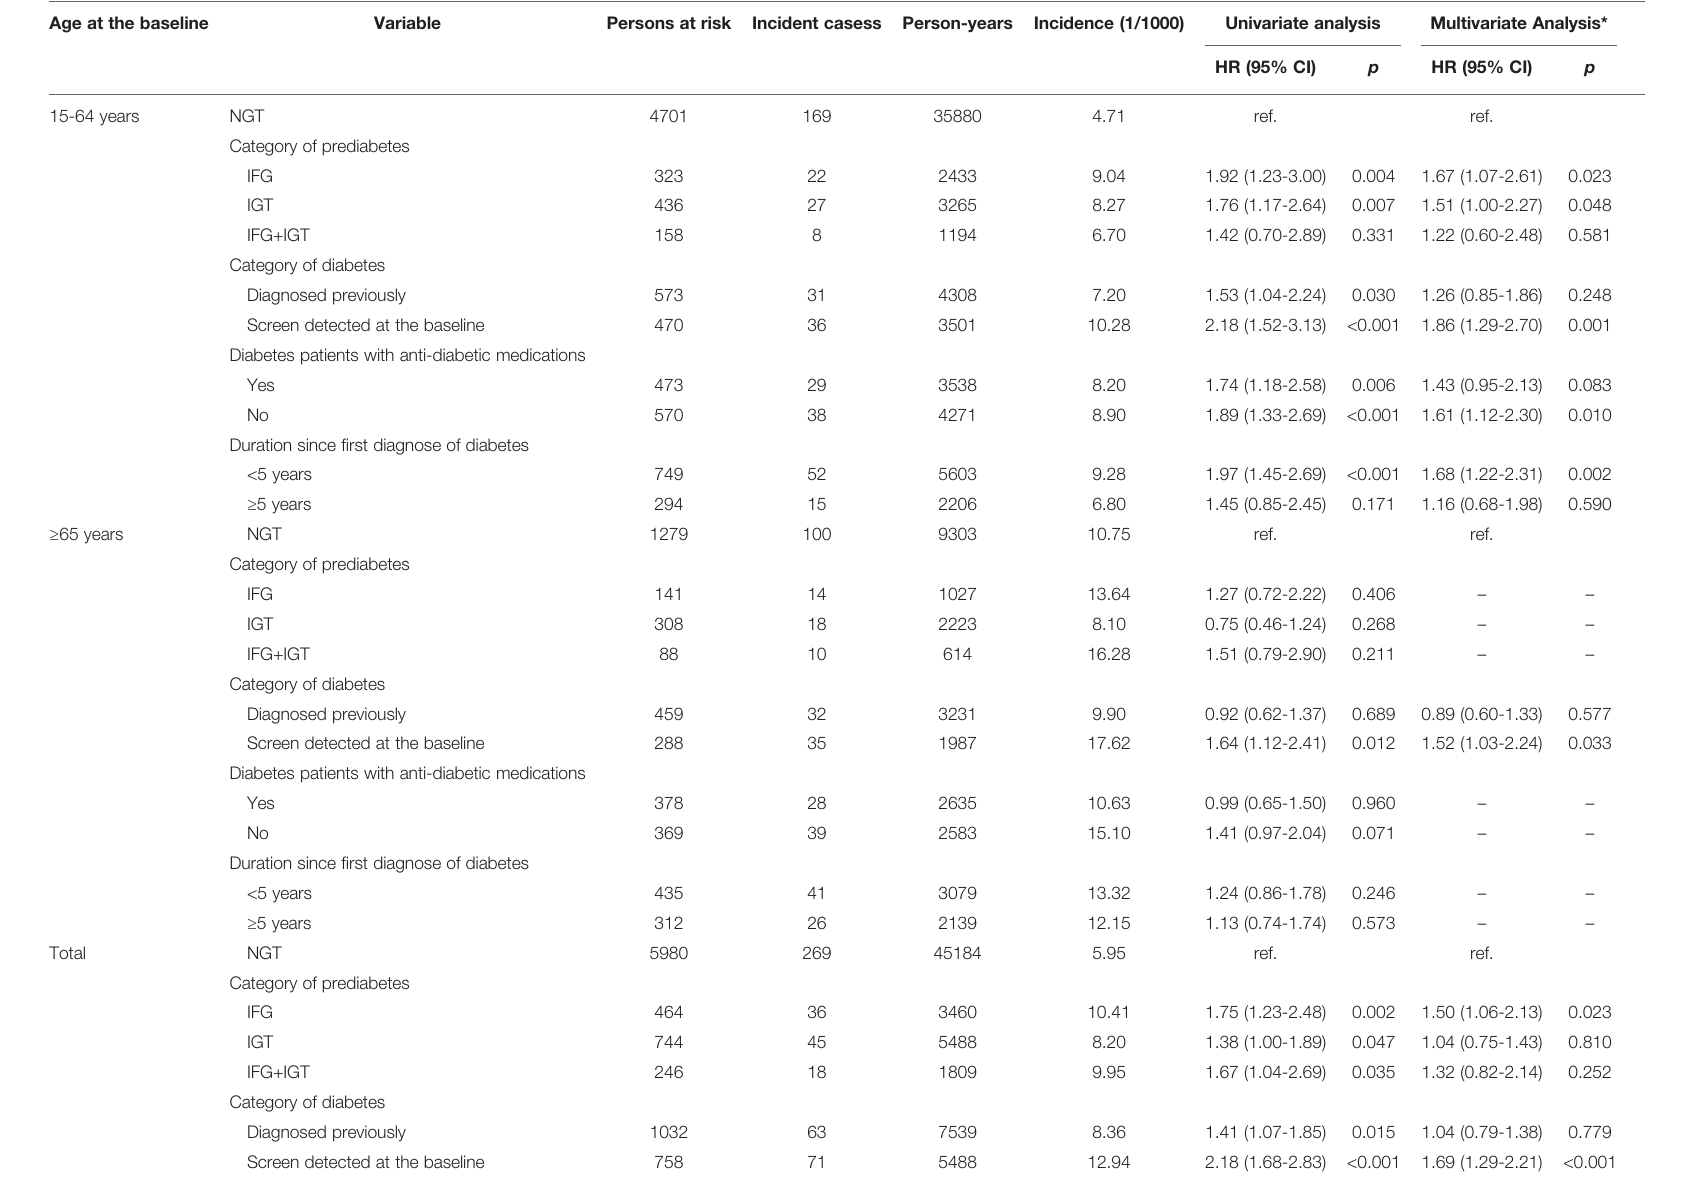
TABLE 3 | Effects of glucose intolerance on cancer incidence in the study participants. Age at the